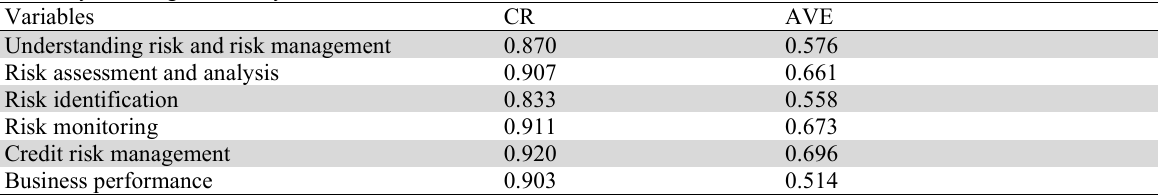
Reliability, convergent validity